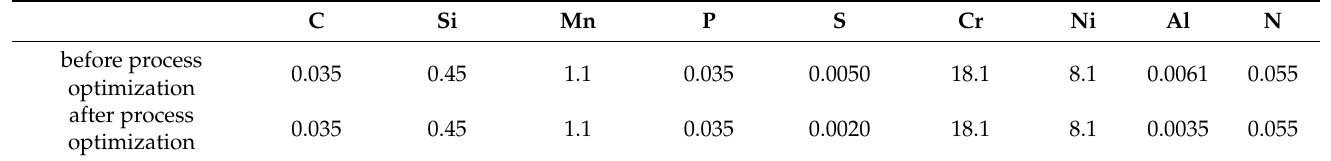
Table 11. The liquid steel composition before and after the process optimization (mass%).